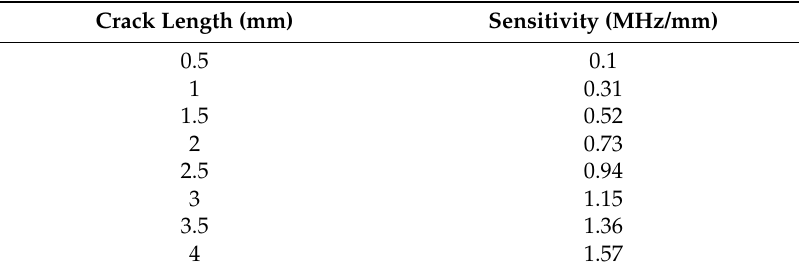
Table 3. The sensitivity of small scale crack size.